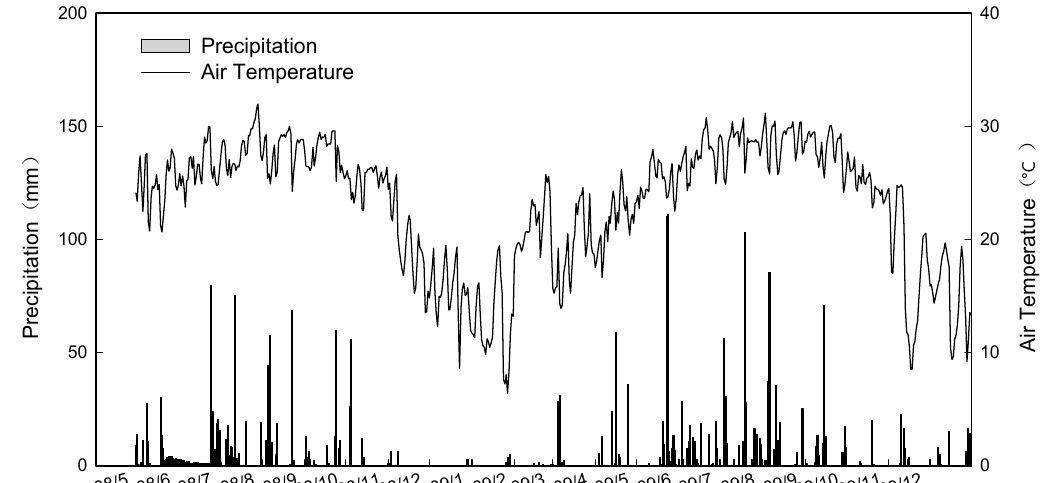
Figure A2 . Precipitation and air temperature in Heshan station during the study period. Figure A2. Precipitation and air temperature in Heshan station during the study